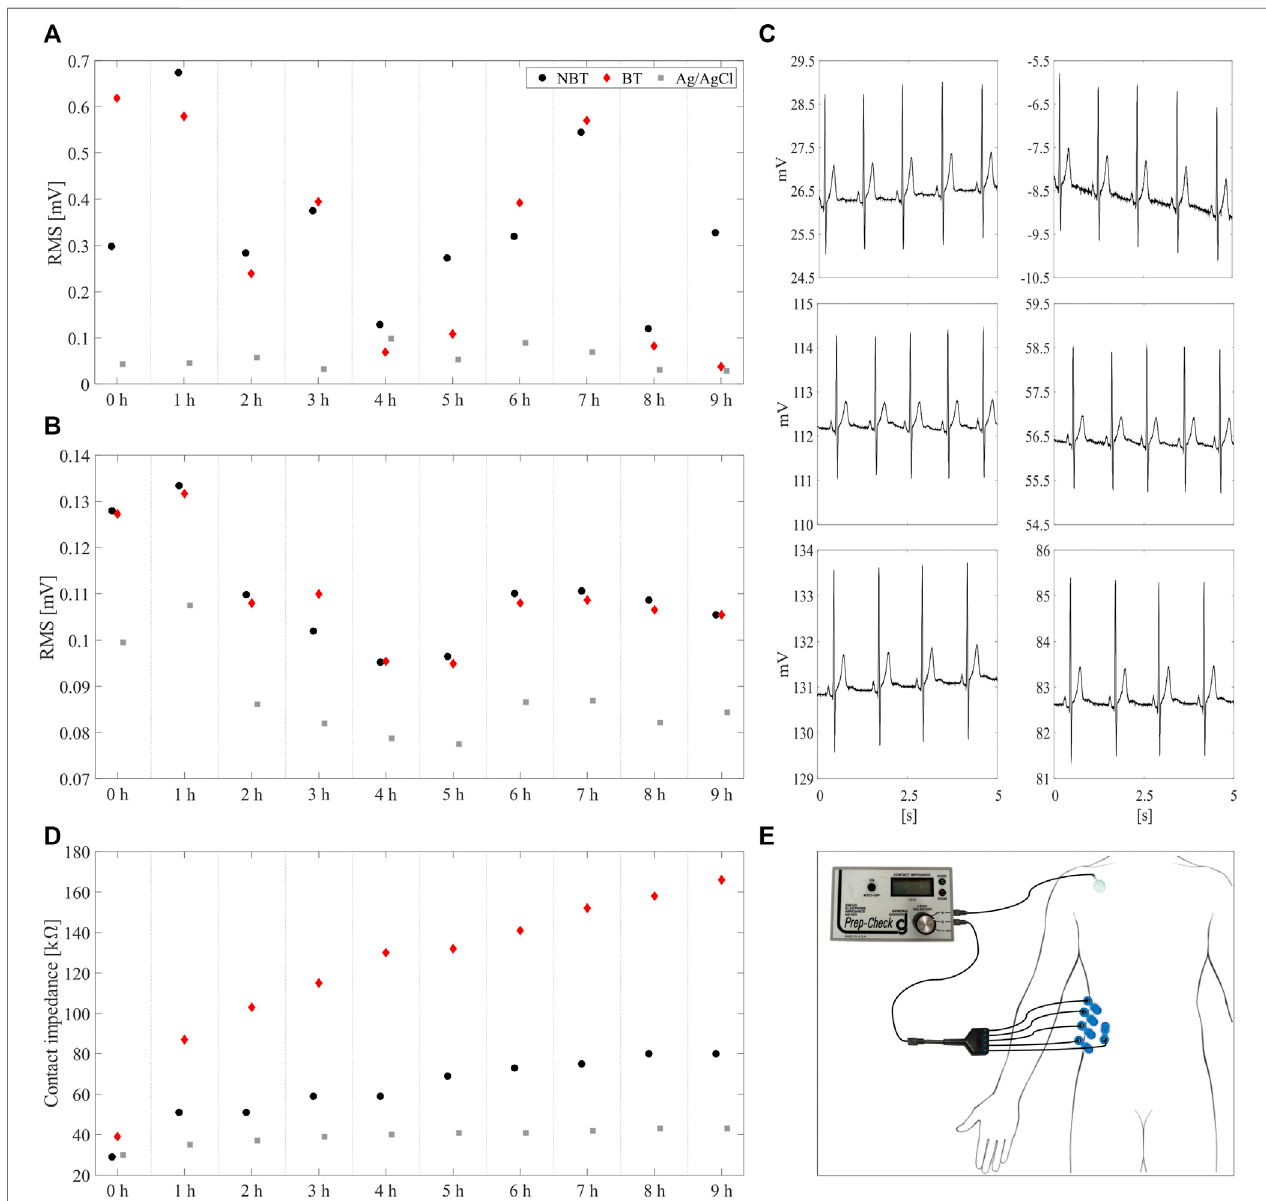
FIGURE 10 | Root-mean-square level estimations for (A) low-frequency and (B) high-frequency noise performed on ECG signals recorded over 9 hours by the (cid:129) three differentelectrodetypes, i.e.non-breathabletattoo (NBT, ,breathable tattoo(BT, ◆ )and gelled Ag/AgCl( ■ ).In (C) ,a5s-zoom onNBT(left column)and BT(right column) signals recorded at different hours, i.e. at 0 h (top), 4 h (middle) and 9 h (bottom), is reported. (D) evolution of the skin-electrode impedance. It can be noticed how the impedance relative to the skin-breathable electrode interface increases faster than the other two; this is due to the faster evaporation of the thin layer of sweat, which causes a faster drying out of the interface itself, thus a slight increase of the contact impedance. (E) Positioning of the electrodes for the impedance evaluation during the ECG